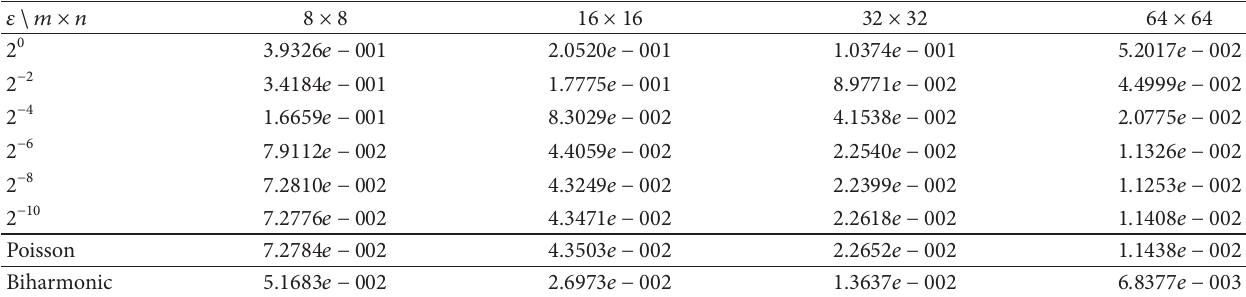
Table 3: The errors |‖𝑢 − 𝑢 ℎ ‖| 𝜀,ℎ /|‖𝑢‖| 𝜀,ℎ employing approximation form (14) under mesh 2. 𝜀 \ 𝑚 × 𝑛 8 × 8 16 ×